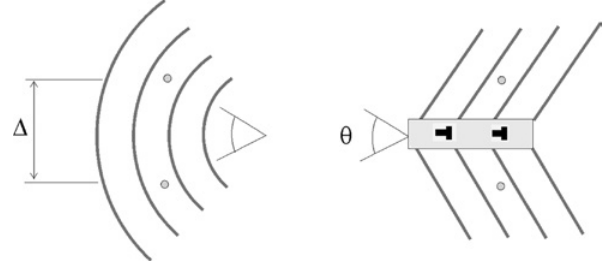
Figure 1: Apparent similarity of lattice misorientations θ when determined with a finite spacing Δ in a defect-free field of elastic distortion (left) and across a dislocation boundary